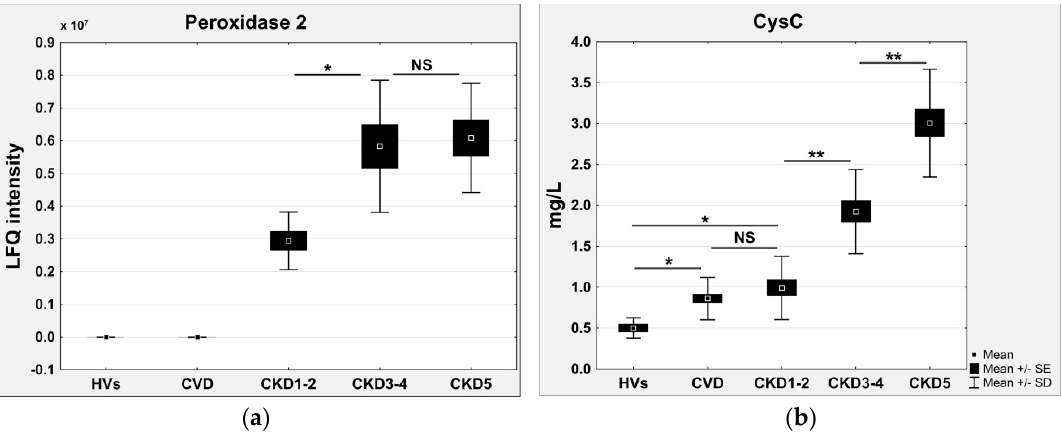
Figure 5. ( a ) Relative abundance of peroxiredoxin 2 (PRDX2) in HVs, CVD, CKD1-2, CKD3-4, and CKD5 groups based on LFQ intensities; ( b ) ELISA measurements of cysC. Charts show mean, SE, and SD for all analyzed plasma samples. Student’s t -tests were completed and statistical significance is indicated (* p < 0.05, ** p < 0.001, NS: non-significant).